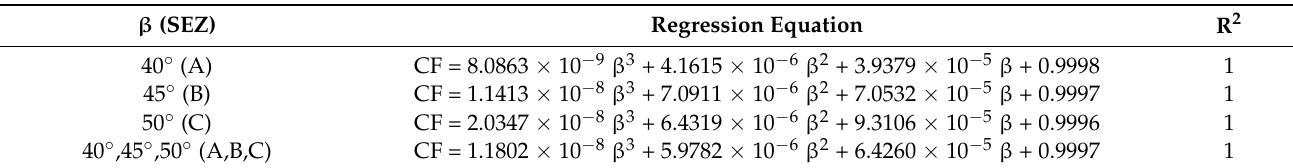
Figure 12. Variation of the correction factor, CF, as function of the ground-albedo ratio, ρ r , for various tilt angles, β , for a flat plane tracking the Sun in Saudi Arabia, averaged over the period 2005–2016. The blue lines correspond to CF = ρ r = 1. Notice that the datum point (1,1) is the site of Arar (#24), as expected. The black dotted lines are the best fits to the CFs of all sites having the same tilt angle. Table 4. Regression equations for the best-fit curves to the CF– β data points averaged over all respective sites in the period 2005–2016, together with their R 2 values, for SEZ-A, SEZ-B, SEZ-C, and all